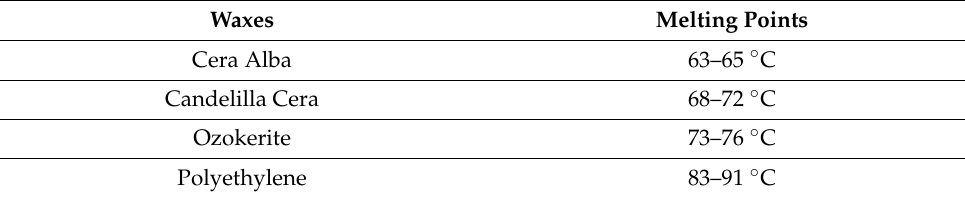
Table 9. Melting points of waxes contained in the formula.